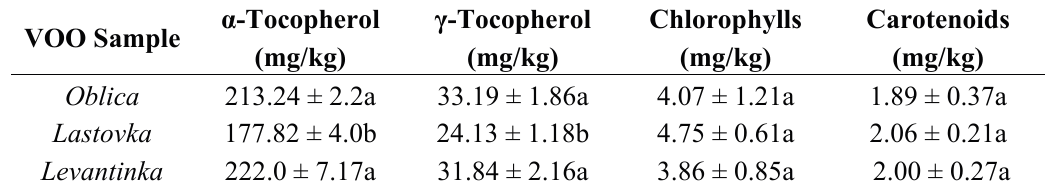
Table 3. The amount of α -tocopherol, γ -tocopherol, total chlorophylls and carotenoids of Oblica , Lastovka and Levantinka